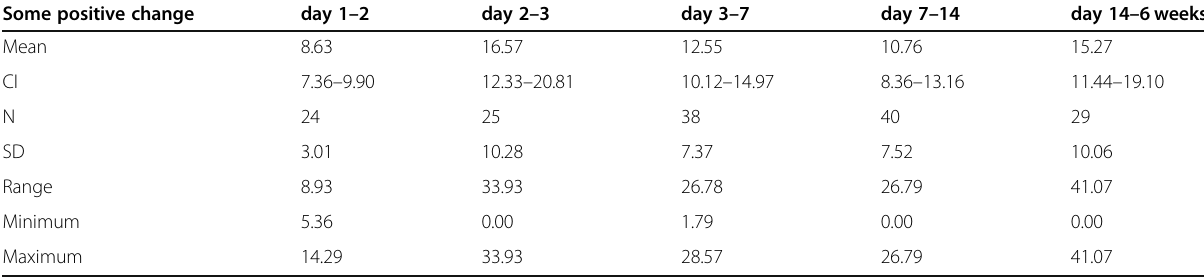
Table 14 Mean overall ‘ some positive change ’ OARS scores Some positive